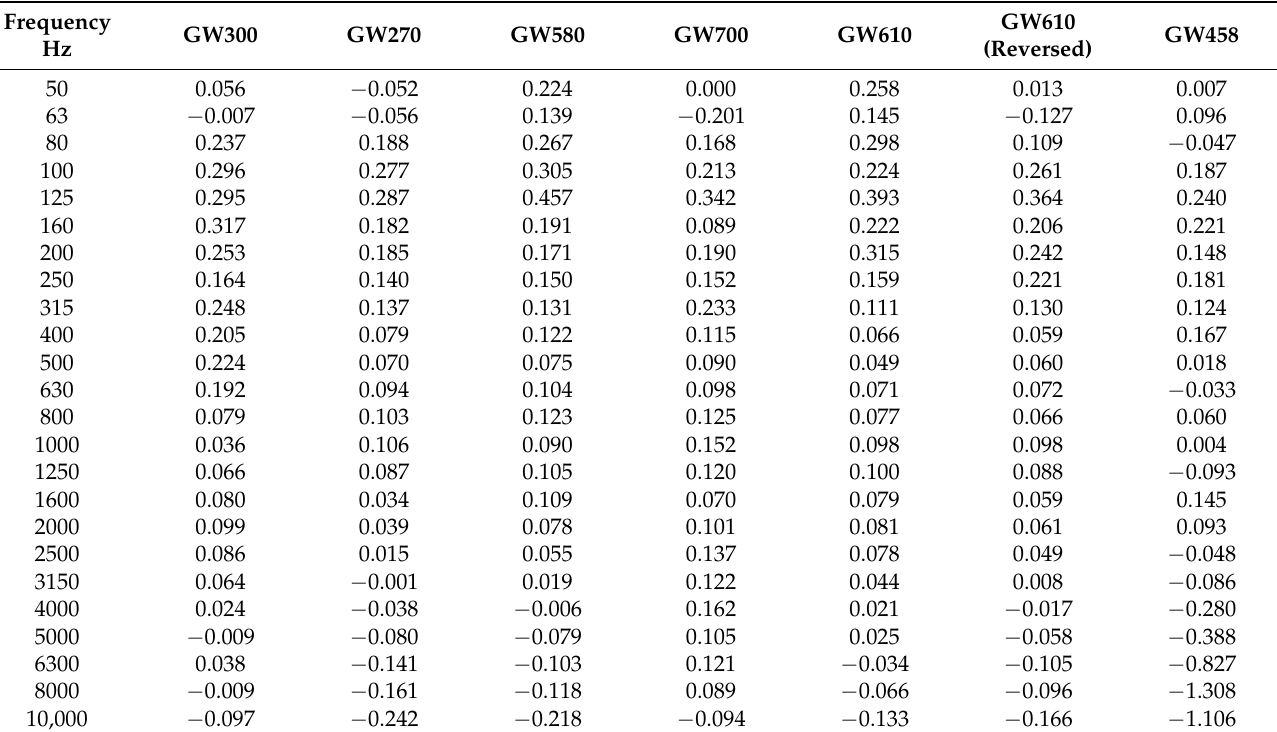
Table 6. The measured absorption coefficient of studied PVC